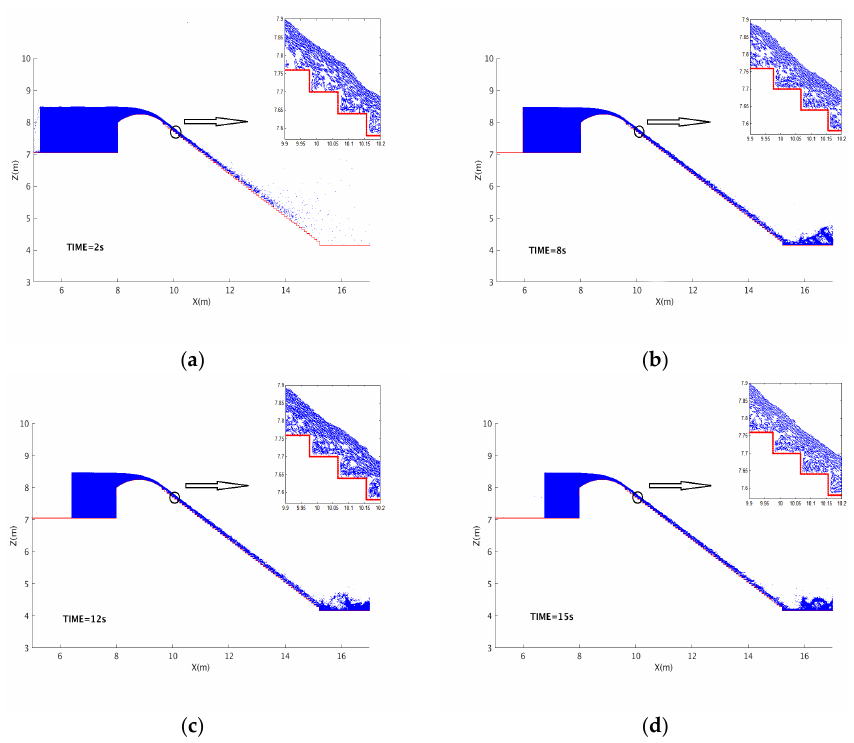
Figure 8. Computed particle snapshots of 62-step spillway flow at different time instants at: ( a ) t = 2 s; ( b ) t = 8 s; ( c ) t = 12 s; ( d ) t = 15 s.